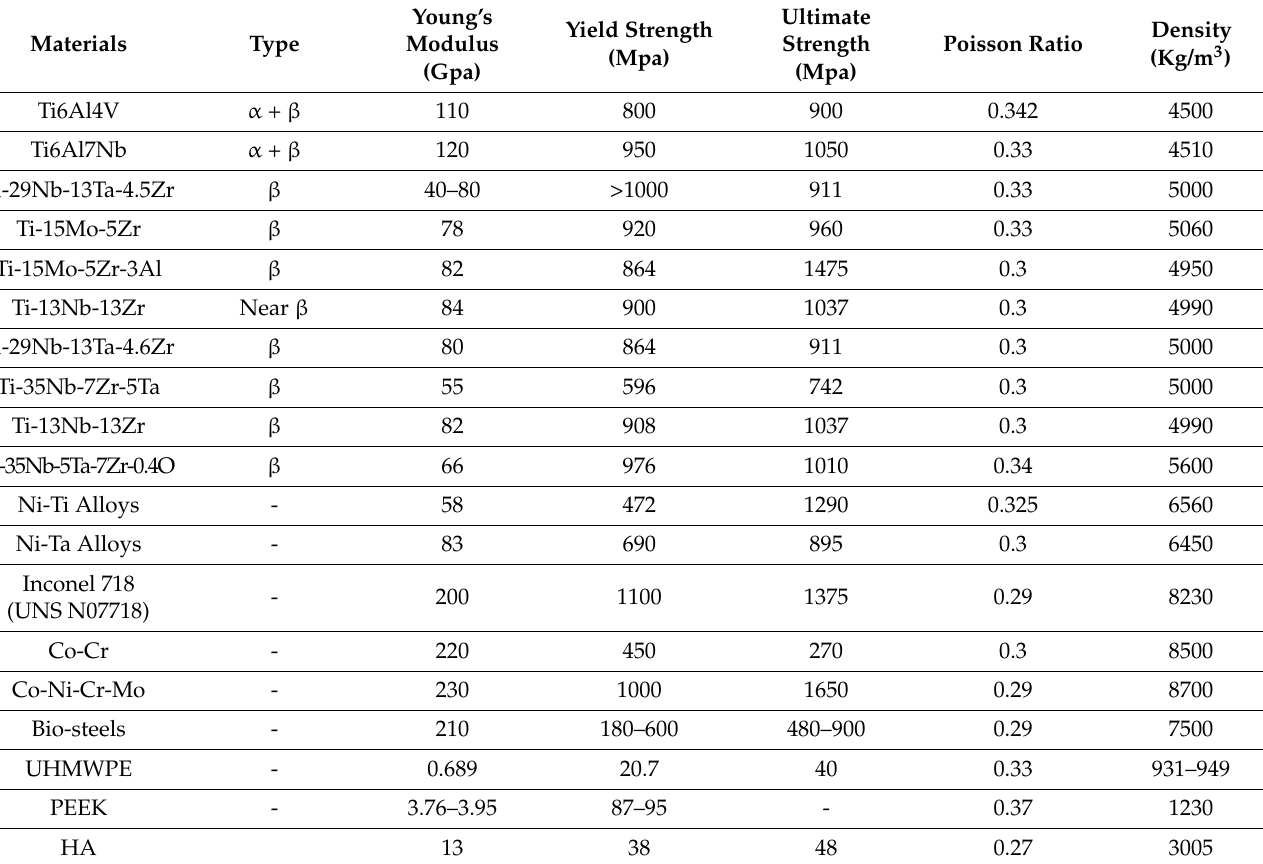
Table 1. Material properties of commercially deployed biomaterial alloys in THRs